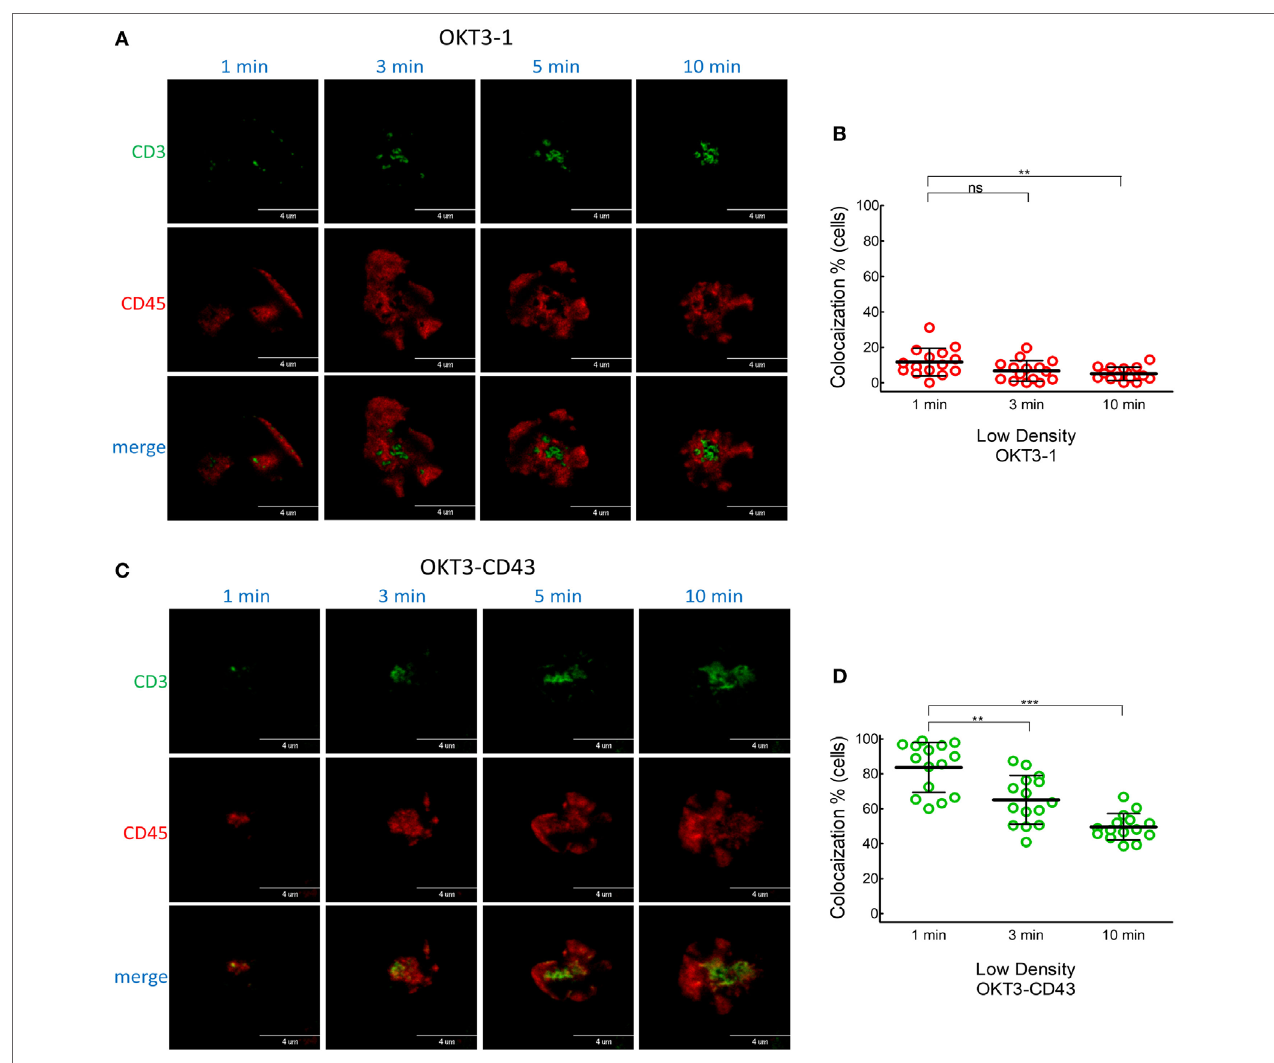
FigUre 9 | CD45 and CD3 co-localization in T cells activated by low densities of membrane-tethered anti-CD3 scFv. Co-localization of CD3 and CD45 induced by low densities of OKT3-1 and OKT3-CD43 as measured in Figure 8a . (a) A representative cell was imaged for CD3 (green) and CD45 (red) by TIRF microscopy at 1, 3, 5, and 10 min after contact with OKT3-1 on a planar lipid bilayer. (B) Co-localization percentage between CD3 and CD45 measured by intensity of overlapping pixels for whole Jurkat T cells activated by OKT3-1 ( n = 15 cells). Bars, SD. (c) A representative cell was imaged for CD3 (green) and CD45 (red) by TIRF microscopy at 1, 3, 5, and 10 min after contact with OKT3-CD43 on a planar lipid bilayer. (D) Co-localization percentage between CD3 and CD45 measured by intensity of overlapping pixels for whole Jurkat T cells activated by OKT3-CD43 ( n = 15). Bars,